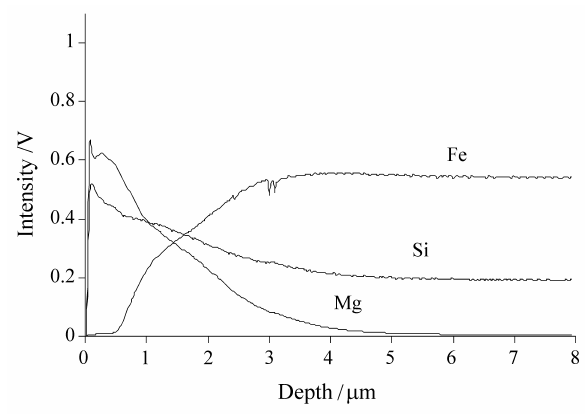
Figure 5. GDS intensity of Fe, Si and Mg as a function of depth from the outermost surface for the sample coated with a MgO